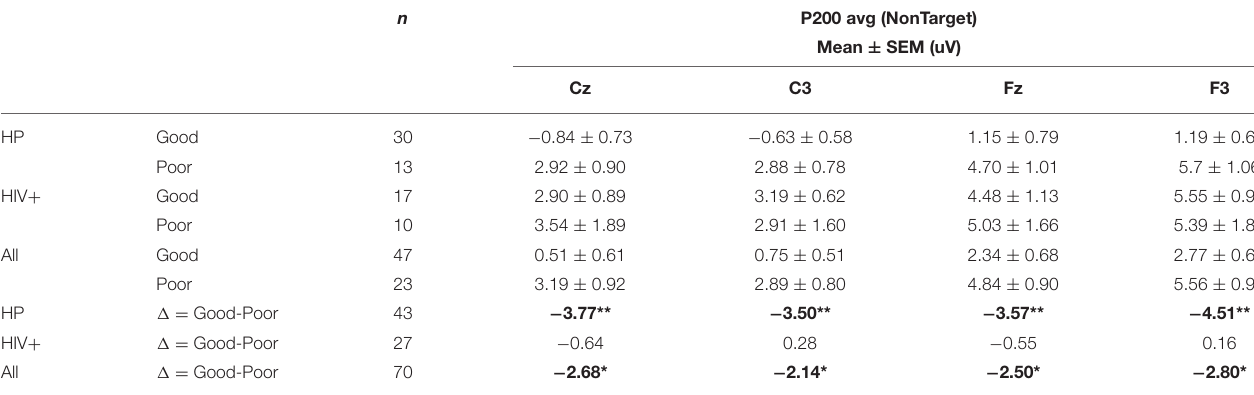
TABLE 2 | Average P200 amplitude for all groups and subgroups based on simulator driving performance.